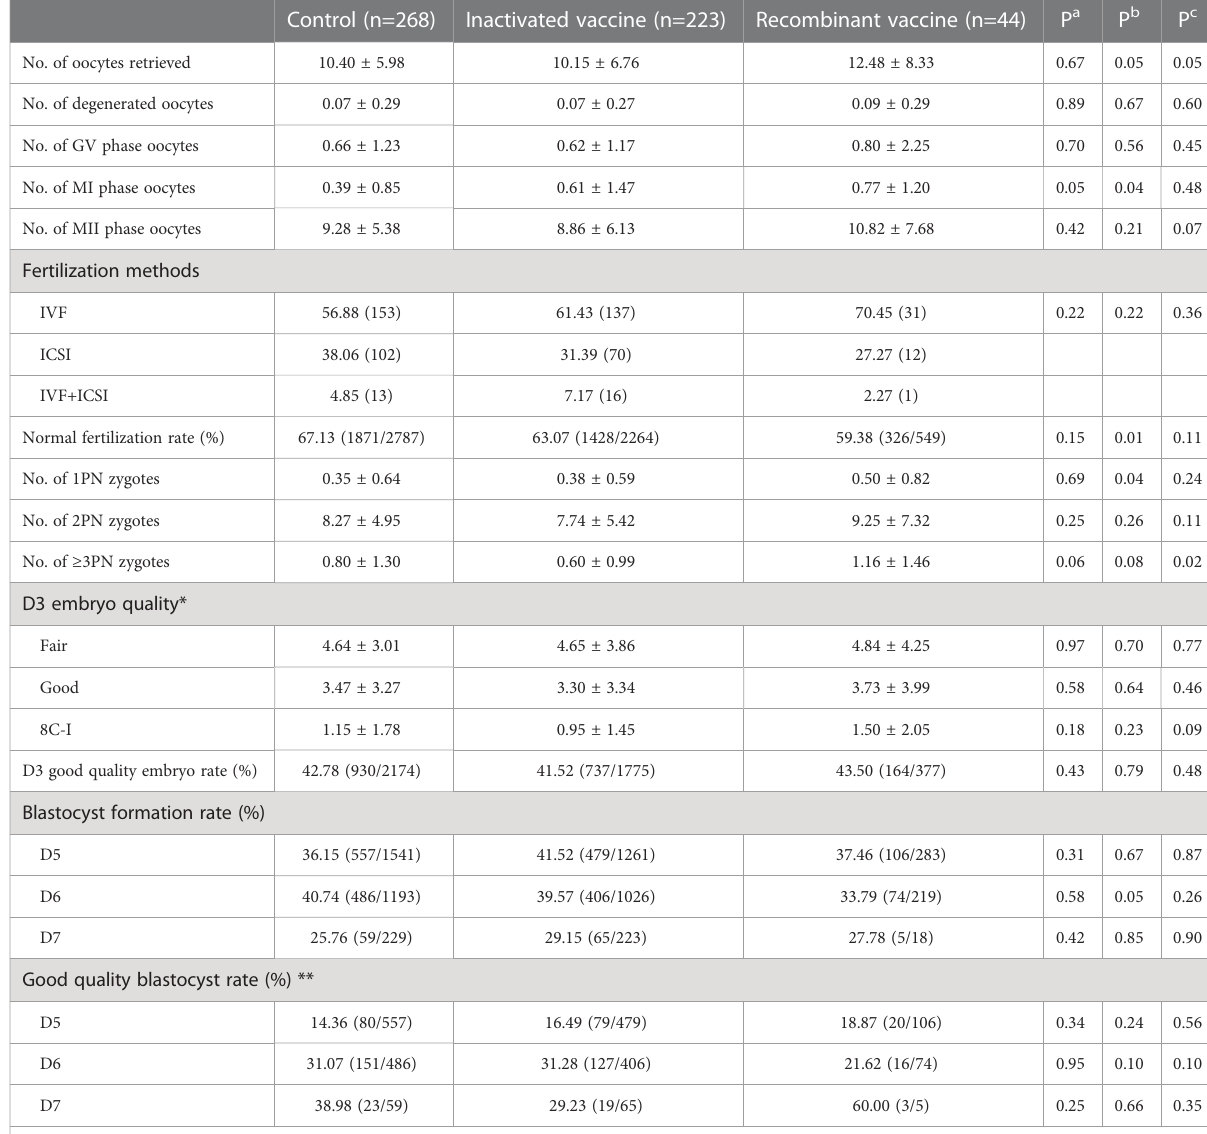
TABLE 2 Laboratory outcomes in women received different type of vaccines and